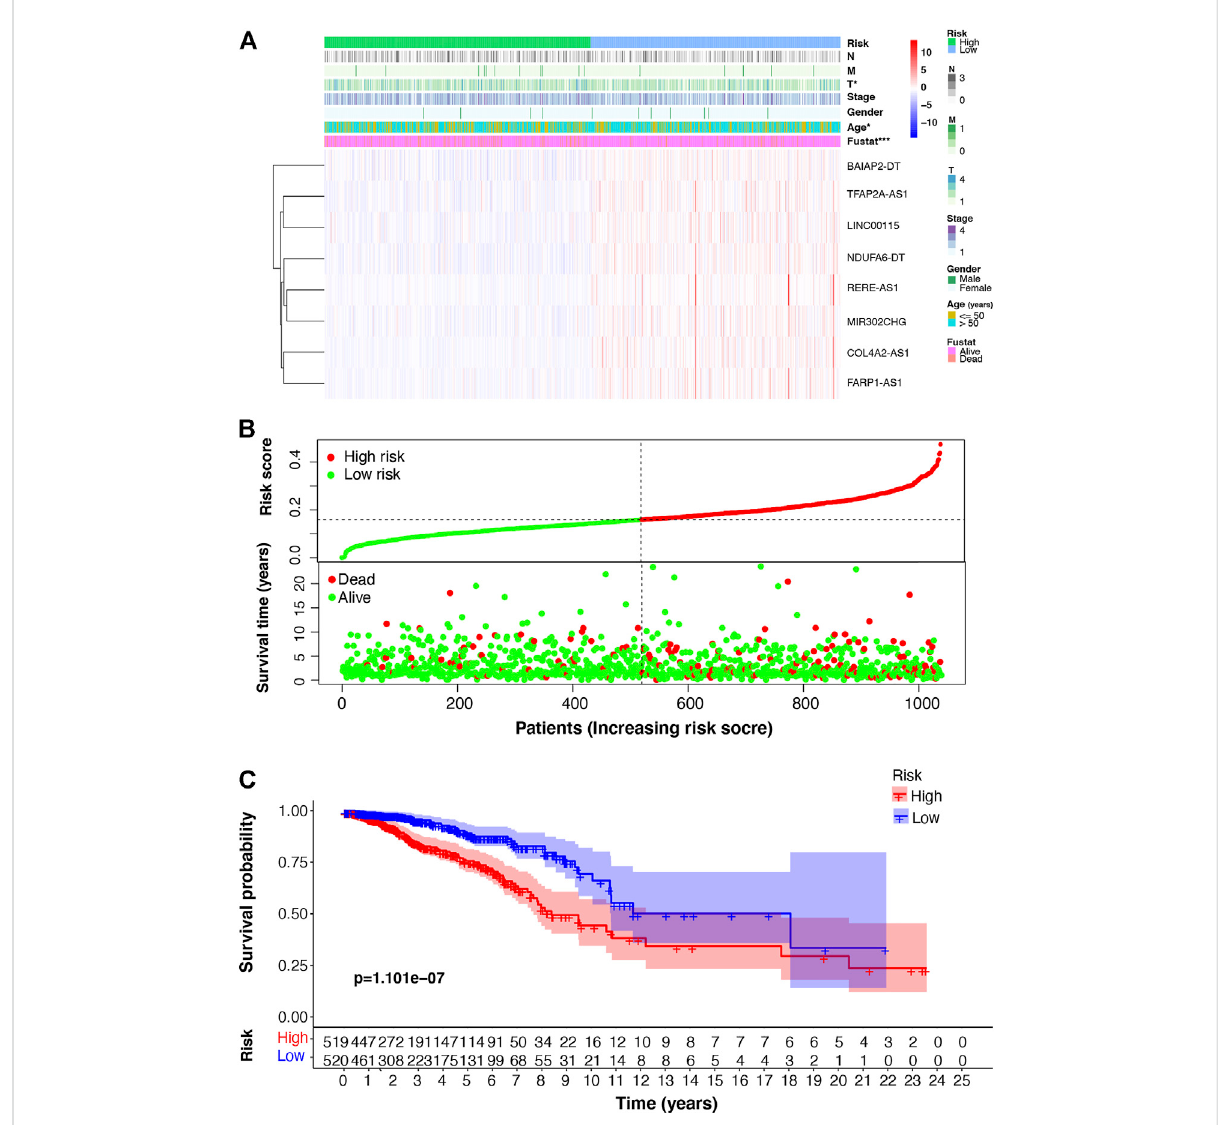
FIGURE 4 m7G-associated lncRNA (m7G-lncRNA) prognostic signature based on the eight prognosis-related m7G-lncRNAs. (A) Heat map of the difference in expression of the m7G-lncRNAs and clinicopathologic factors between the high- and low-risk groups (B) Distribution of the relationship between the risk score and patient survival status. (C) Kaplan – Meier survival analysis in the high- and low-risk groups (* p < 0.05; * * * p <